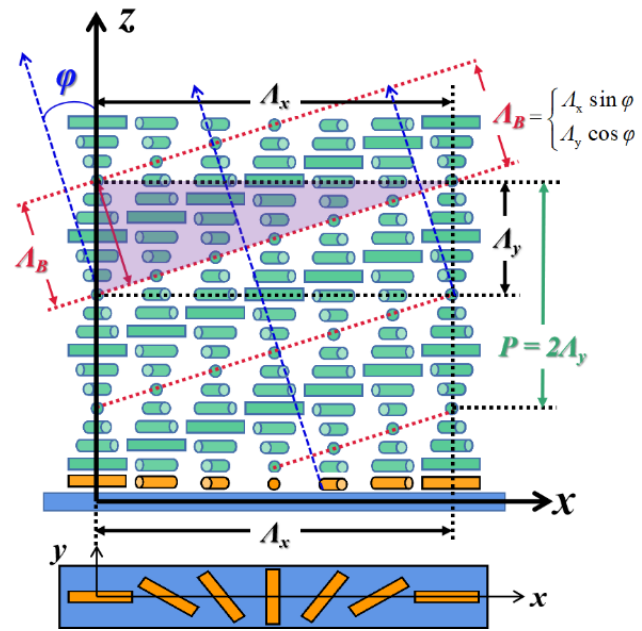
Figure 3. Schematic drawing of a tilted grating structure combining the horizontal and the vertical periods, Λ x and Λ y . The refractive index distribution presents a series of surfaces with tilt angle φ .